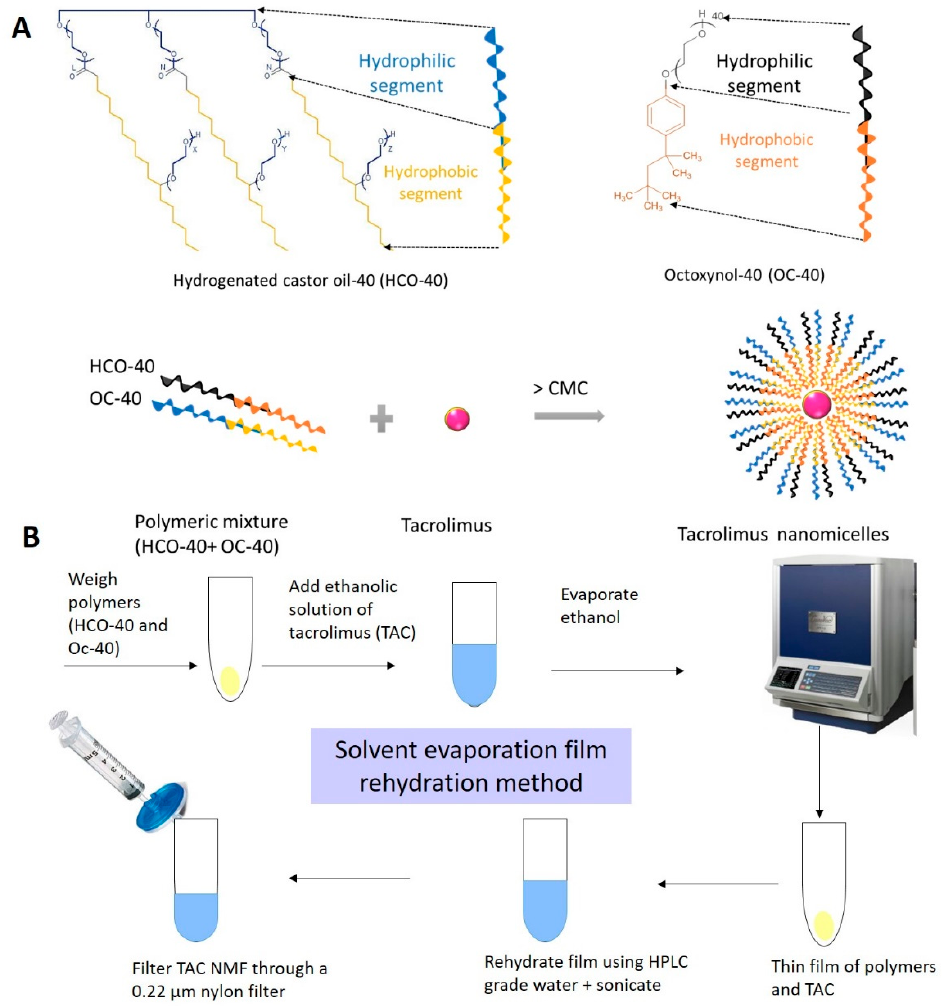
Figure 1. Pictorial representation of tacrolimus nanomicellar (TAC-NMF) formulation development. ( A ) Self-assembly of TAC-NMF nanomicelles from amphiphilic PEG-Hydrodenated castor oil-40 (HCO-40) and Octyxonal-40 (OC-40) amphiphilic polymers above critical micellar concentration (CMC). This allows entrapment of hydrophobic drug tacrilimus in the core of the nanomicelles. ( B ) Schematic representation for prepartaion of TAC-NMF using solvent evaporation-film rehydration method.